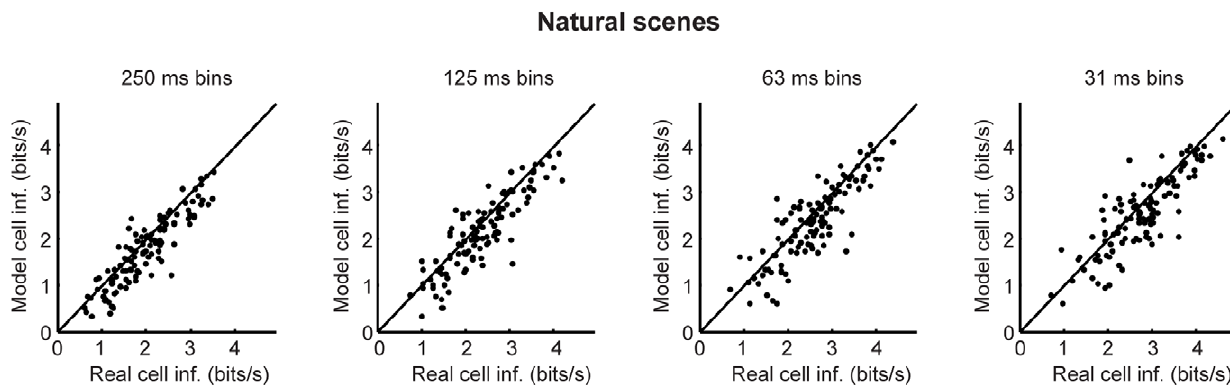
Figure 3. The amount of information carried by the model cells closely matched that of their real cell counterparts, when the stimulus set consisted of natural scene movies. As in Figs. 1 and 2, the mutual information between each model cell’s responses and the stimuli was calculated and plotted against the mutual information between its corresponding real cell’s responses and the stimuli. Bin sizes ranged from 250 ms to 31 ms; n =113 cells; stimulus entropy was 4.9 bits (30 one-second movie snippets). Note that there is scatter both above and below the line because of data limitation.